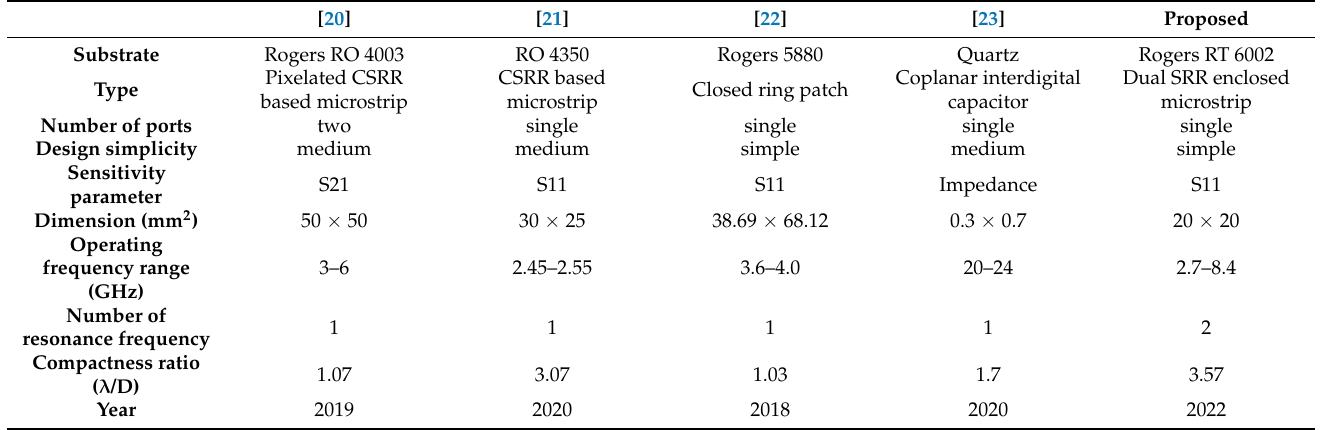
Table 6. Comparative study with different microstrip-based